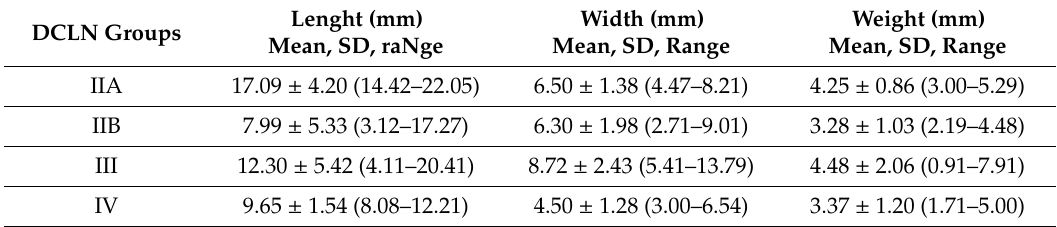
Table 1. Size of the deep cervical lymph